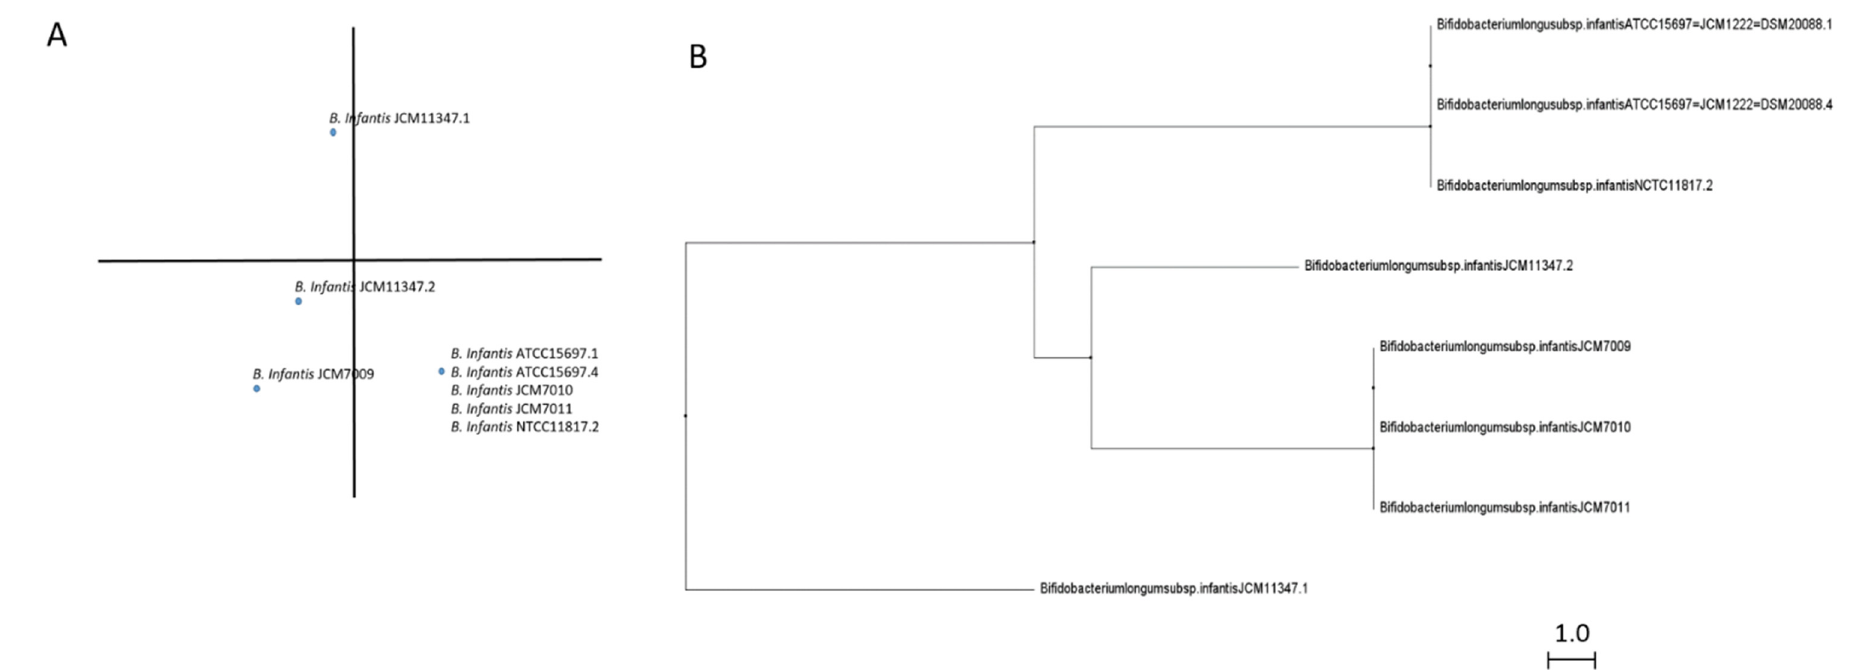
Figure 4. Phylogenetic analysis of bifidobacterial GH151 fucosidases. PCA ( A ) and cladogram tree ( B ) distributions of bifidobacterial GH151 complete fucosidase sequences listed in CAZy, released from Jalview 2.11.1.4 software using the neighbor-joining method.